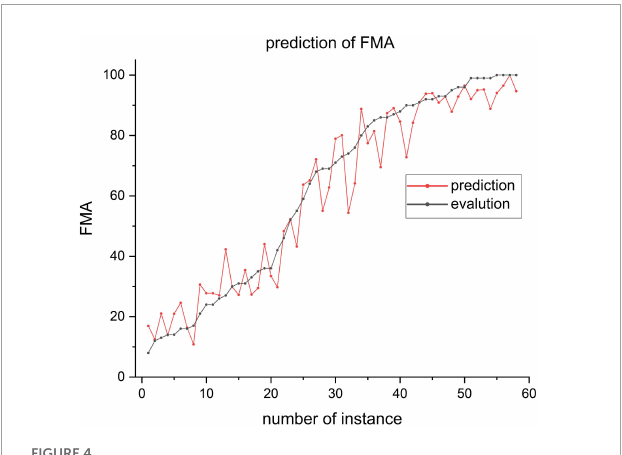
FIGURE4 Predictive and actual FMA value of 58 patients.